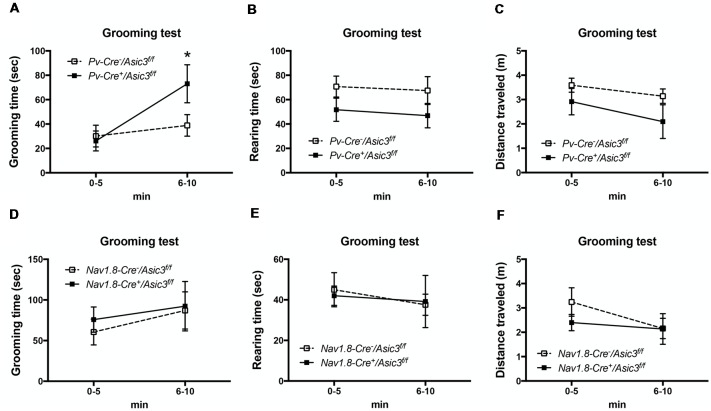
Deletion of Asic3 in parvalbumin-positive (Pv+) neurons increased grooming behavior. (A)
Pv-Cre+/Asic3f/f mice showed more grooming behavior than Pv-Cre−/Asic3f/f mice (genotype: F(1,14) = 1.738, p = 0.2085; time: F(1,14) = 7.431, p = 0.0164; interaction: F(1,14) = 3.517, p = 0.0817; Post hoc analysis: *p < 0.05 0–5 min vs. 6–10 min in Pv-Cre+/Asic3f/f). N = 8 mice per group. No difference was found in (B) rearing and (C) distance traveled behaviors between in Pv-Cre+/Asic3f/f and Pv-Cre−/Asic3f/f mice. No difference was found in (D) grooming behavior, (E) rearing, and (F) distance traveled behaviors between Nav1.8-Cre+/Asic3f/f and Nav1.8-Cre−/Asic3f/f mice. N = 7–9 mice per group. Data are mean ± SEM. Data analyzed by two-way ANOVA.